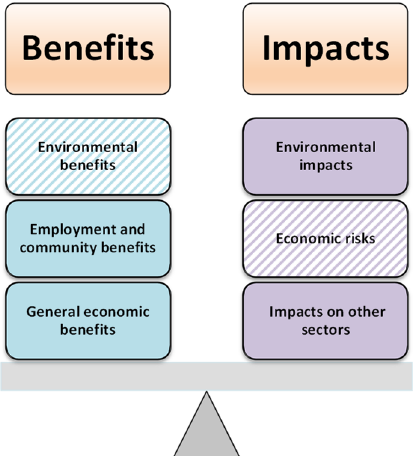
Figure 1. Adapted categories for the assessment of balance of perceived benefits over impacts (dashed categories have been newly added) (modified based on [22]).